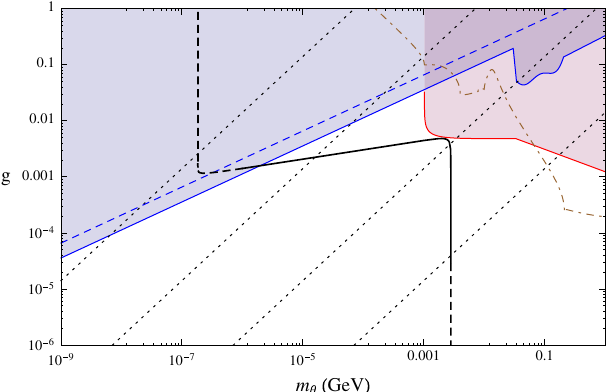
FIG. 3. The constraints on the DM lifetime in the m - g plane, (cid:1) ¼ 0 : 05 eV . The thick black curve, corresponding to the for m (cid:3) correct DM relic density, as well as the dotted vertical lines, , are the same as presented corresponding to constant values of m N & 1 keV , because DM is in Fig. 1. The curve is dashed for m (cid:1) warm inthisregion (see thetext), andfor g & 10 (cid:1) 5 ,becauseof the , shown in Fig. 1. The blue solid theoretical bound f < M P (dashed) line is the upper bound on g from DM decays into neutrinos coming from astrophysics and cosmology (from the Universe lifetime); the blue shaded region is therefore excluded. The red solid line is the analog bound for DM decays into e þ e (cid:1) ; the red shaded region is correspondingly excluded. Finally, the brown dash-dotted line is a conservative estimate of the upper bound on g from DM decays into photons (see the